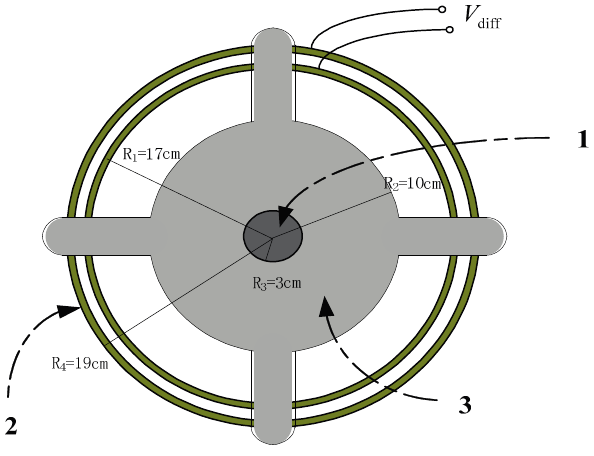
Figure 5. Structure of the improved D-dot probe.